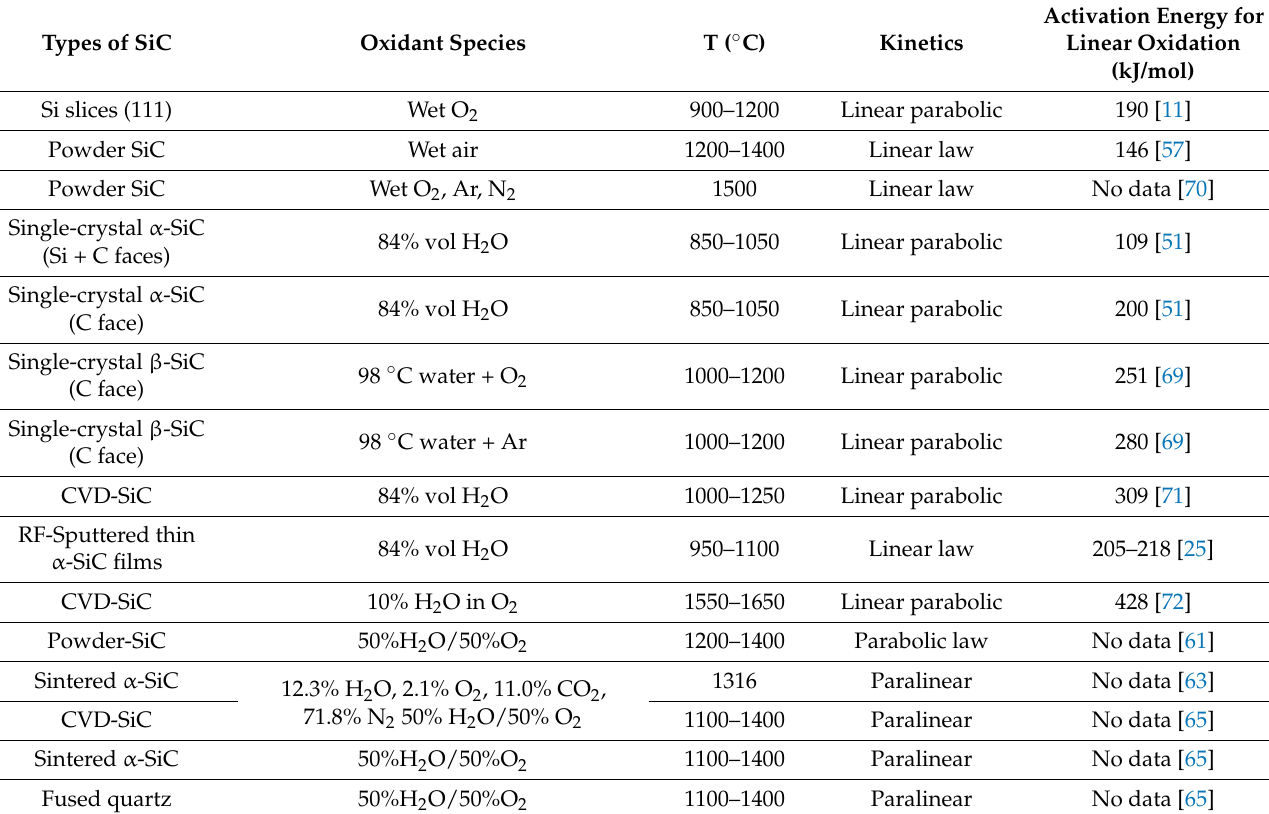
Table 3. Activation energies for linear oxidation of SiC in wet